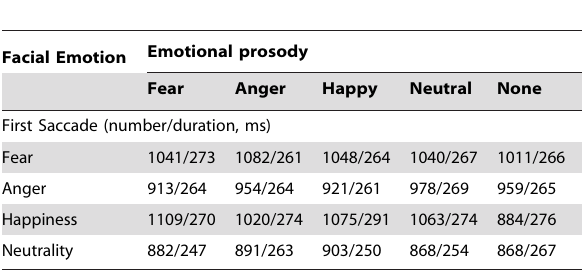
Table 2. Frequency and mean duration (in milliseconds, ms) of fixations measured for the first saccades to a face.